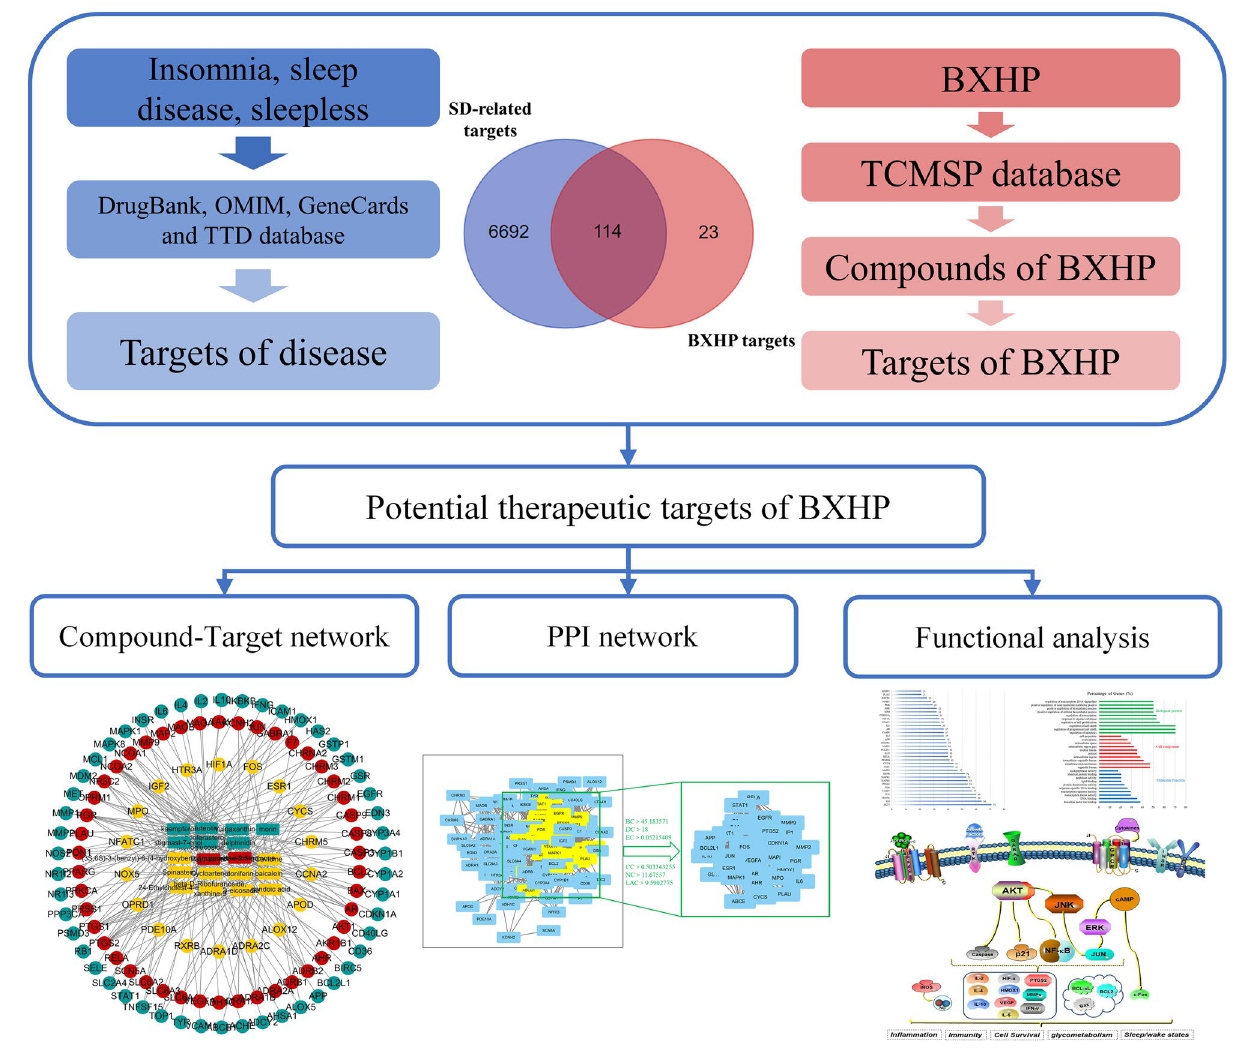
Figure 2. Flowchart of this systems pharmacology-based study exploring the mechanisms of action of Banxia- Xiakucao Chinese Herb Pair (BXHP) for treating sleep disorder. OMIM, Online Mendelian Inheritance in Man; TTD, Therapeutic Target Database; TCMSP, Traditional Chinese Medicine Systems Pharmacology; PPI, protein–protein interaction.